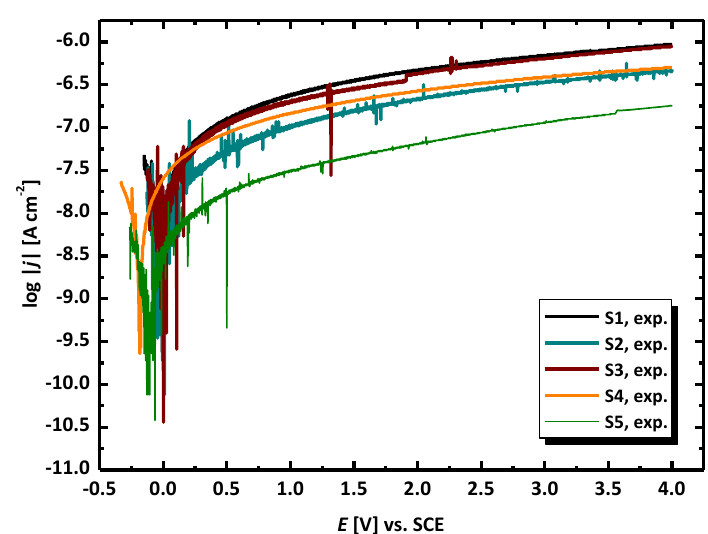
Figure 6. Anodic polarization curves for the AISI 1010 carbon steel electrode in sulfolane at 25 ◦ C showing experimental raw data. S1-electrode after the experiment in pure sulfolane at 95 ◦ C and etching, S2-electrode after the experiment in sulfolane with the addition of 1 vol.% of water at 95 ◦ C and etching, S3-electrode after the experiment in sulfolane with the addition of 2 vol.% of water at 95 ◦ C and etching, S4-electrode after the experiment in sulfolane with the addition of 3 vol.% of water at 95 ◦ C and etching, and S5-electrode after the experiment in sulfolane at 95 ◦ C and without etching of corrosion products.